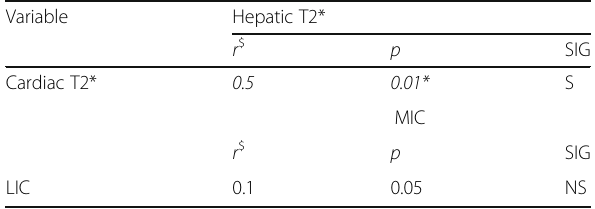
Table 7 Correlation between hepatic and cardiac